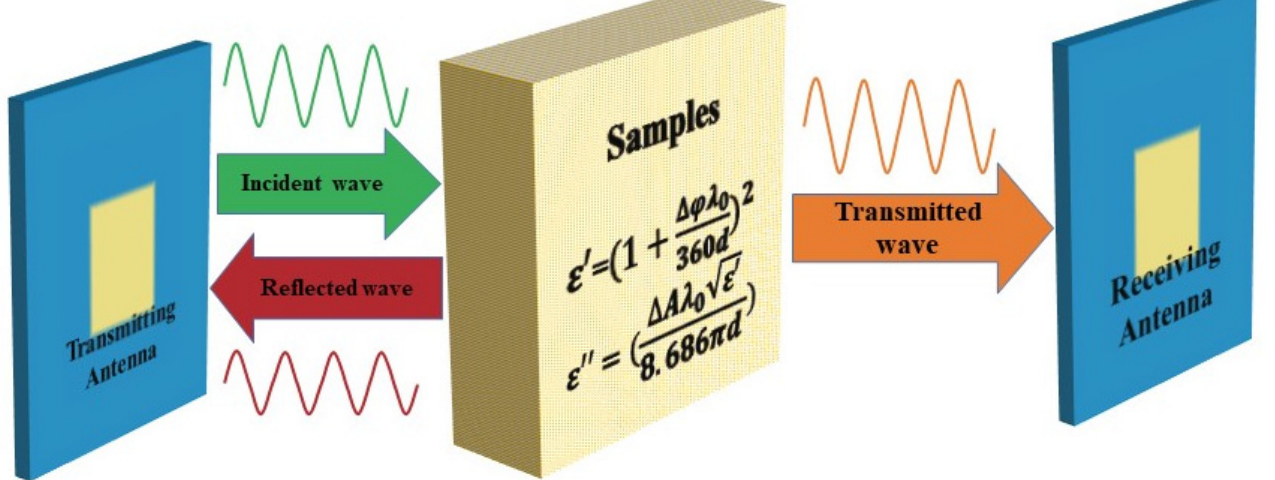
Figure 1. Detection principle of microwave transmission method: ε ’ is the dielectric constant; ε ” is the loss factor; Δ φ is the phase shift, rad; λ 0 is the wavelength, m; D is the sample thickness, m; Δ A is the attenuation, dB.